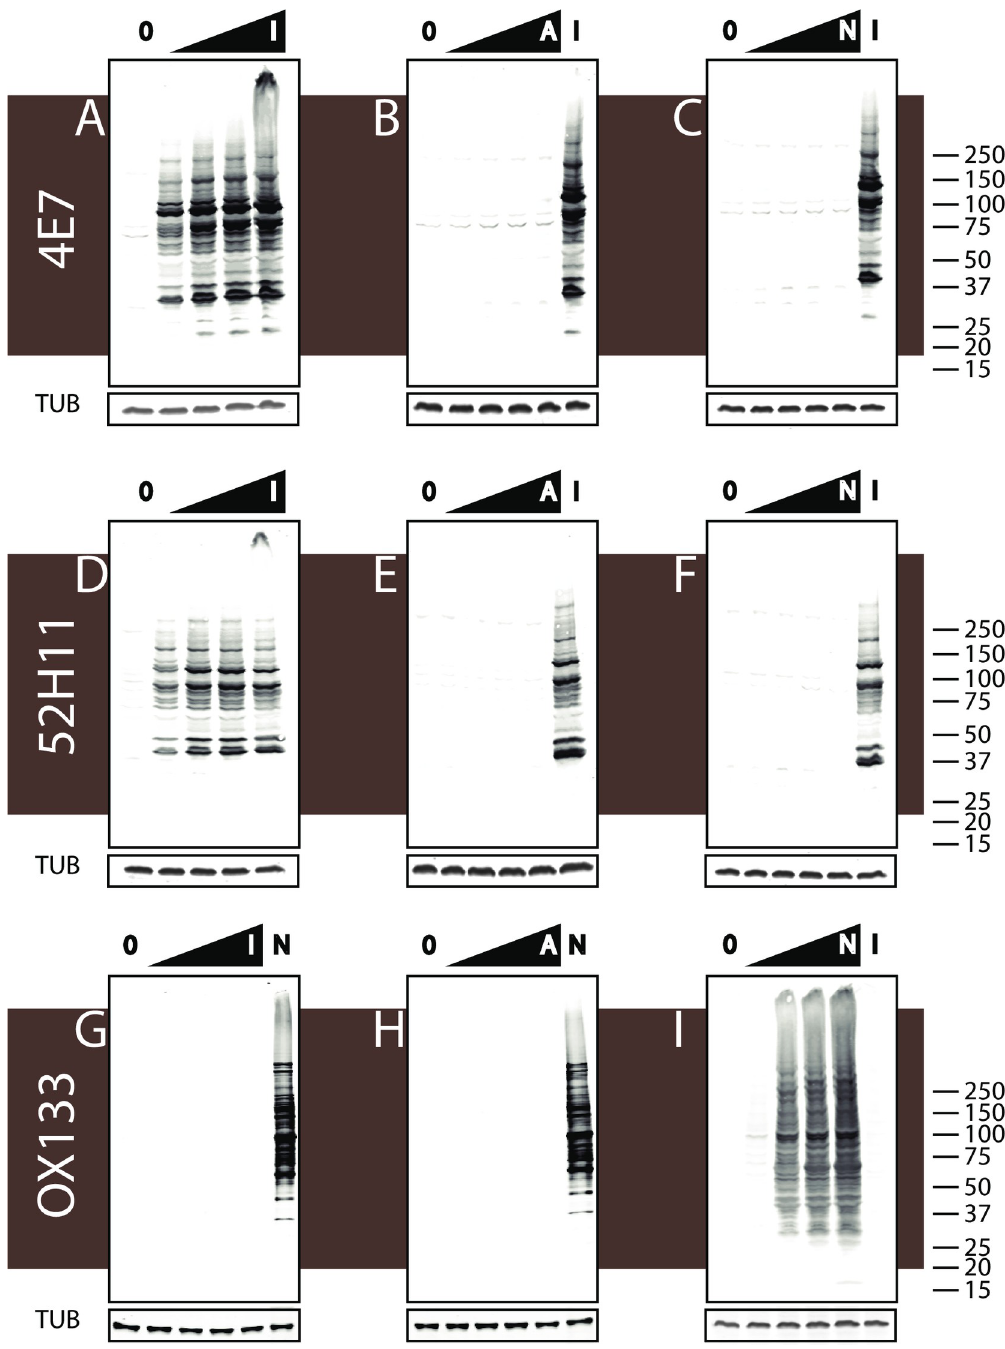
Fig 2. Two monoclonal antibodies recognize multiple proteins in cell lysates treated with IAM. Whole cell lysates from 293 cells were treated with increasing concentrations (0, 0.1, 0.5, 2, 5mM) of cysteine alkylating compounds IAM (A, D, G), acrylamide (B, E, H), and NEM (C, F, I). After Western blotting, panels of proteins were probed with 4E7 (A, B, C), 52H11 (D, E, F) or the NEM-cys targeted antibody OX133 (G, H, I). Lanes marked by 0 contain unmodified protein that serves as a baseline control. Labels in black triangles symbolize treatment dose dependent in IAM (I), acrylamide (A), and NEM (N). In B, C, E, F, and I, lane labeled I on the far right indicates lysates treated with IAM alone (2 mM). In G and H, the lane on the far right labeled with N contains lysates treated with NEM alone (2 mM). TUB = western blot for tubulin as a loading control.